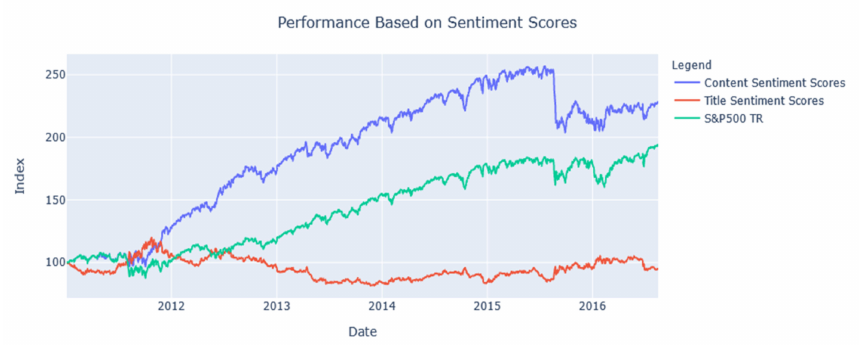
Figure 8. Performance based on sentiment scores.